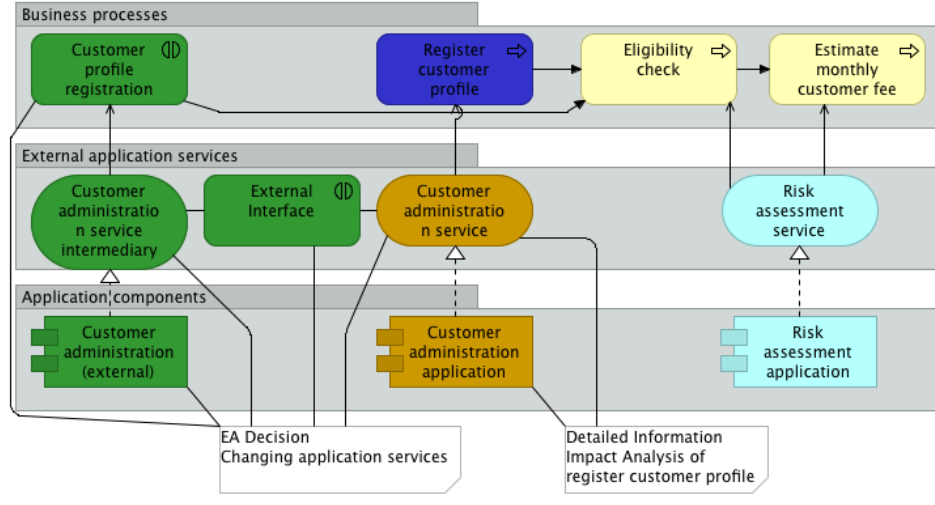
Figure 9. Adapted Application Usage